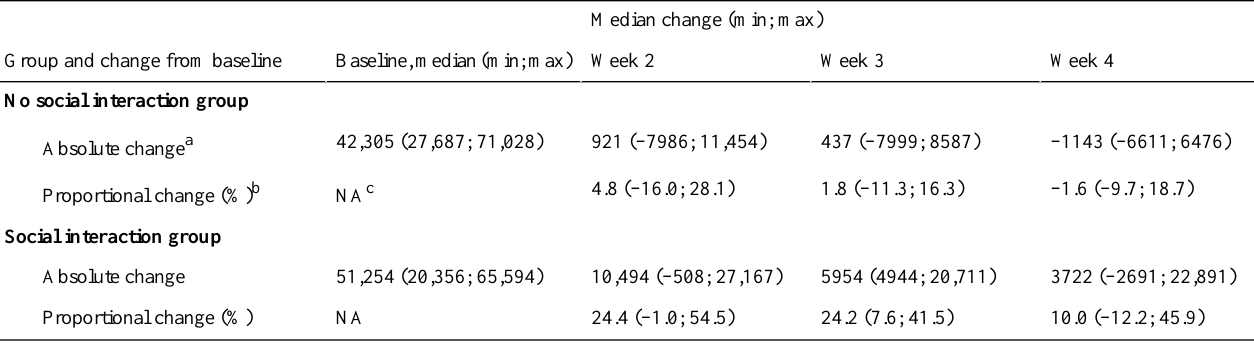
Table 2. Number of steps at baseline for each group and individual variations in subsequent weeks.